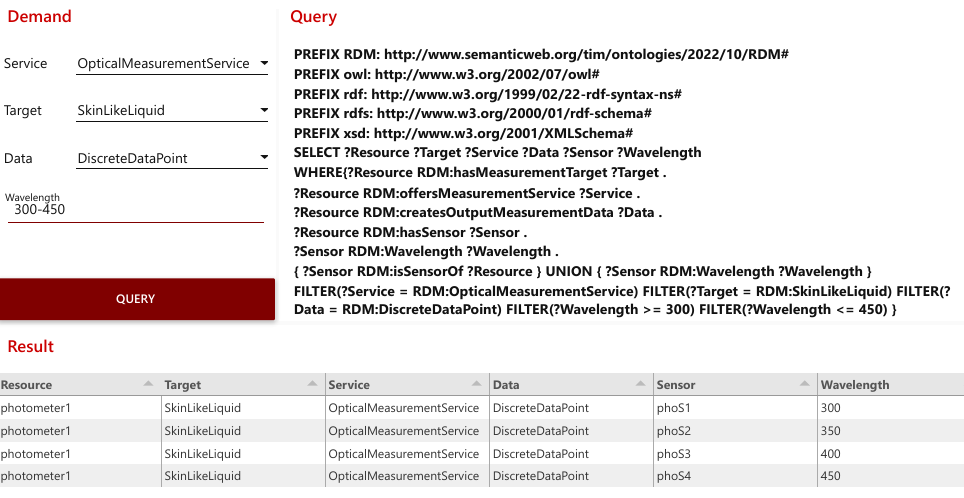
Figure 8. Node-RED Dashboard—Result for Detailed Specification-Driven Device